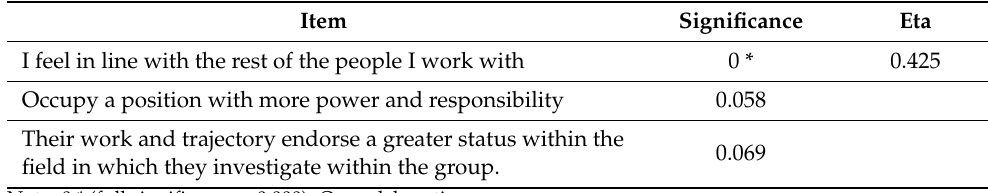
Table 5. Cross Tabulation. Feeling of consonance, Power, Status and